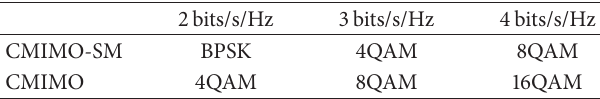
Table 1: Modulation configurations for 2 bits/s/Hz, 3 bits/s/Hz, and 4 bits/s/Hz transmissions using CMIMO-SM and CMIMO.